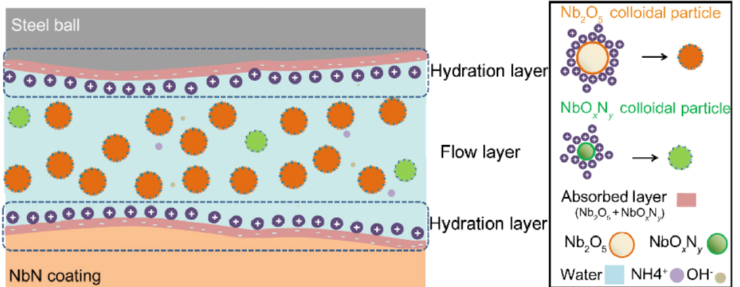
Fig. 17 S chematic of the friction model of NbN in the three-phase contact environment [221]. Reproduced with permission from Ref. [221], © The author(s),